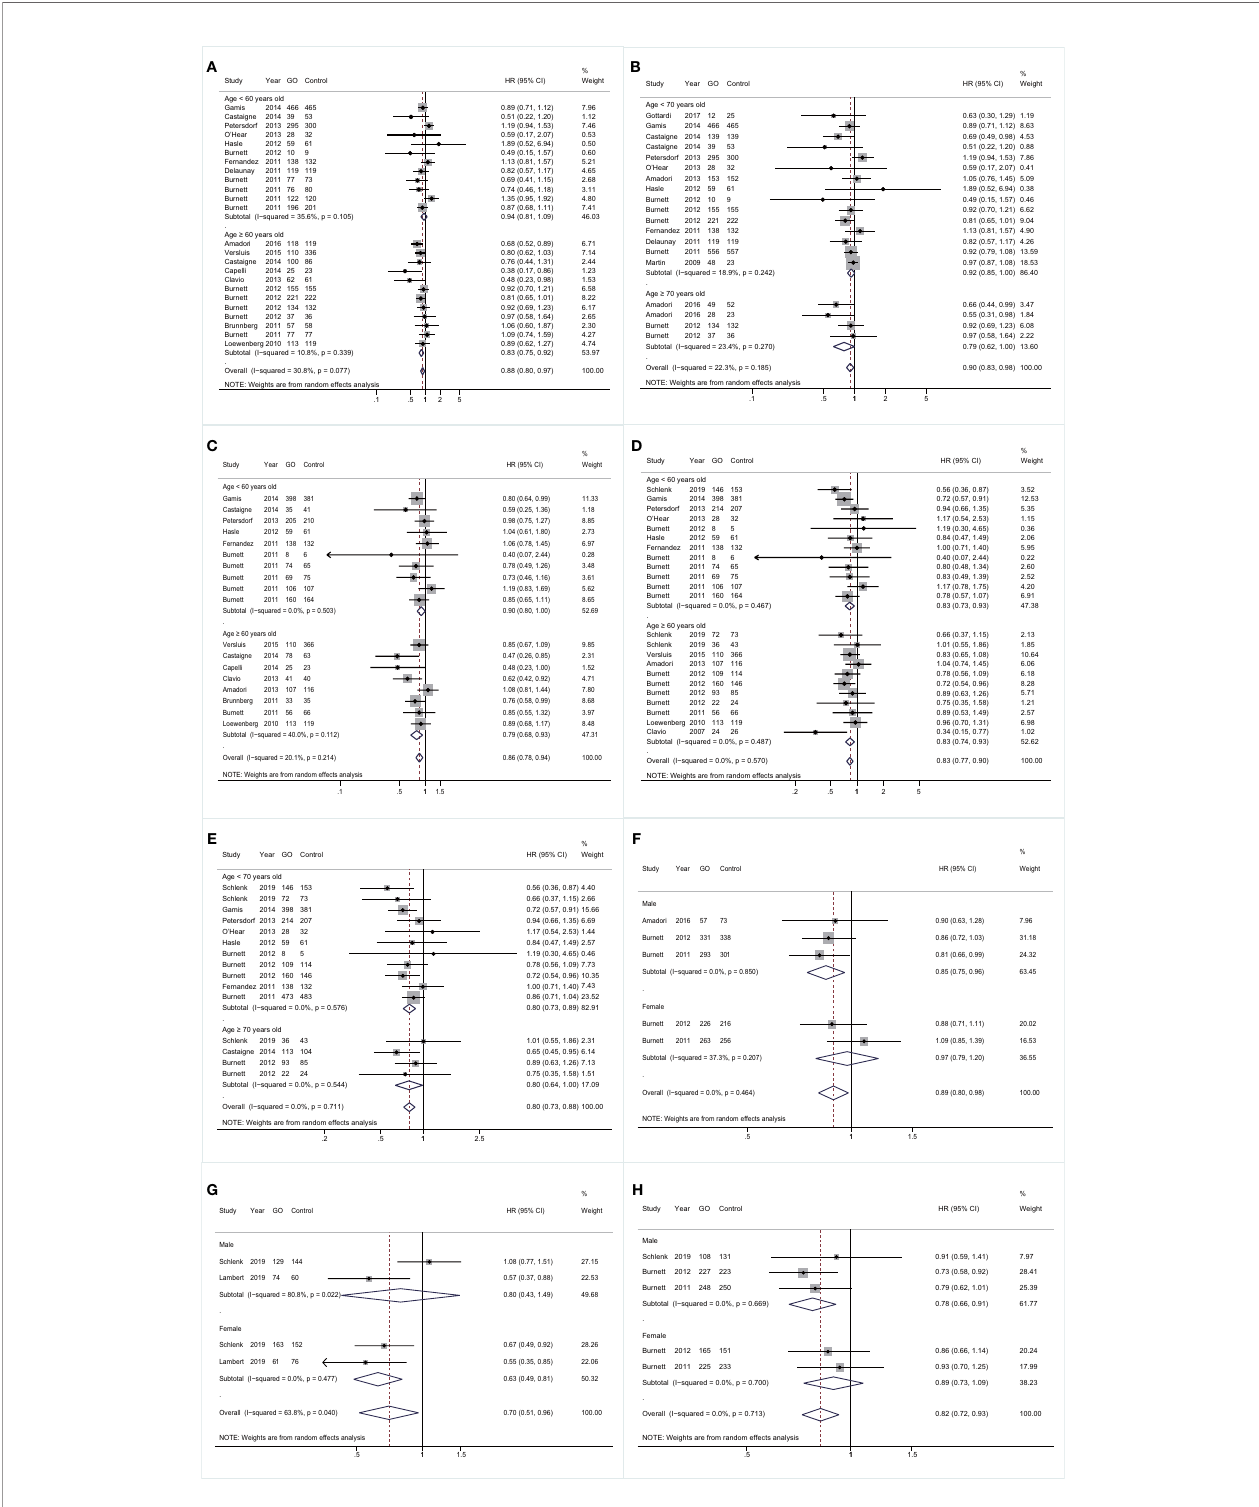
FIGURE 4 | Prognostic subgroup analyses regarding age strati fi cations and gender. (A) OS subgrouped by age (60 years old). (B) OS subgrouped by age (70 years old). (C) RFS subgrouped by age (60 years old). (D) CIR subgrouped by age (60 years old). (E) CIR subgrouped by age (70 years old). (F) OS subgrouped by gender. (G) EFS subgrouped by gender. (H) CIR subgrouped by gender. The diamonds represent the overall summary HR estimates with 95% CI. GO, gemtuzumab ozogamicin; OS, overall survival; EFS, event-free survival; RFS, relapse-free survival; CIR, cumulative incidence of relapse; HR, hazard ratio; 95% CI, 95% con fi dence